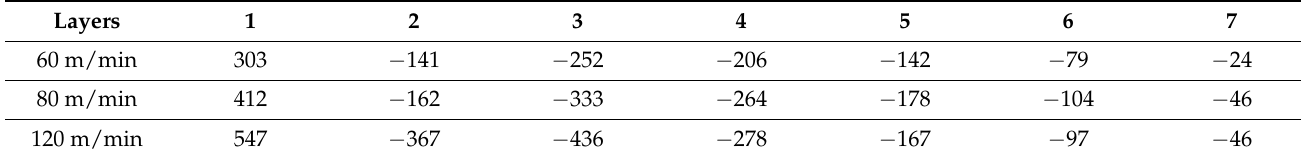
average. Residual stress in each layer is the average value of stress, as shown in Table 3. Table 3. Residual stress in each